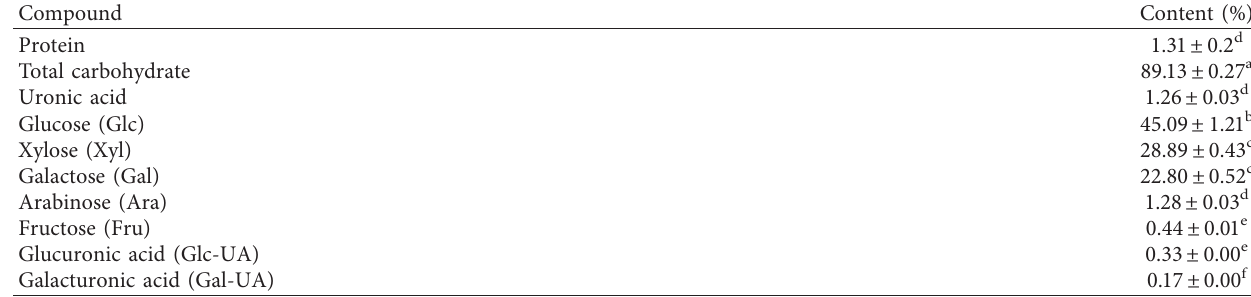
Table 2: Chemical and monosaccharide composition of polysaccharides extracted from TSP.